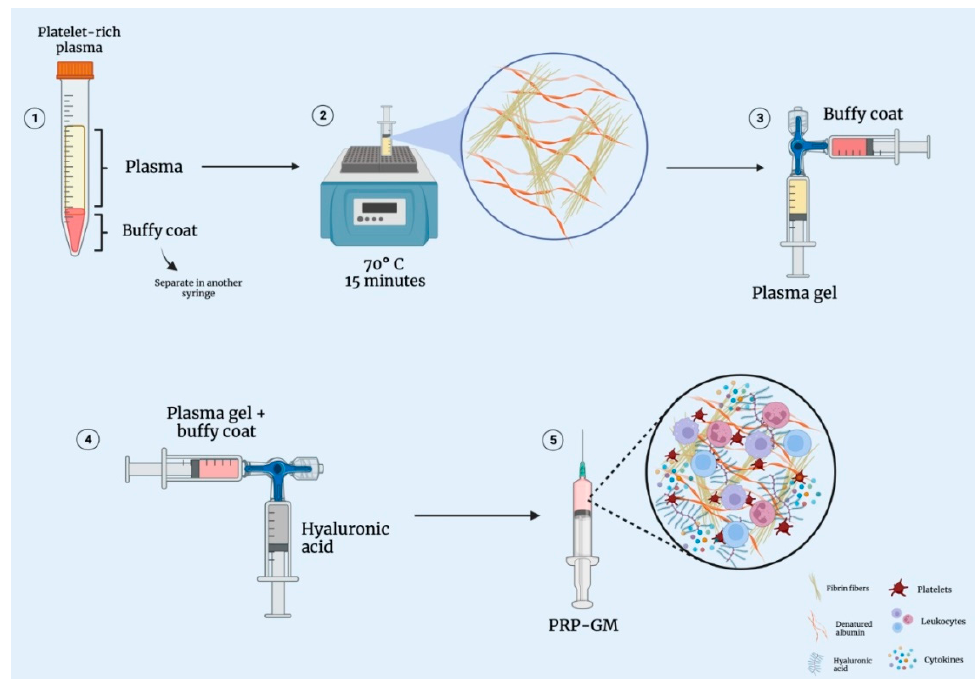
Figure 4. Last step before infiltration. ( A ) The mixed buffy coat and plasma gel are homogenized with hyaluronic acid to obtain the PRP–HA cellular gel matrix; ( B ) The final product, ready for use.